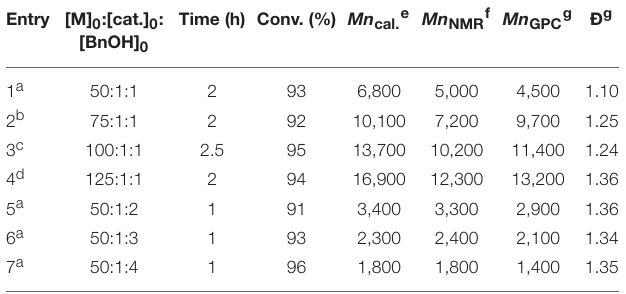
TABLE 2 | Ring opening polymerization of L -lactide by L 4 ZnEt with BnOH.